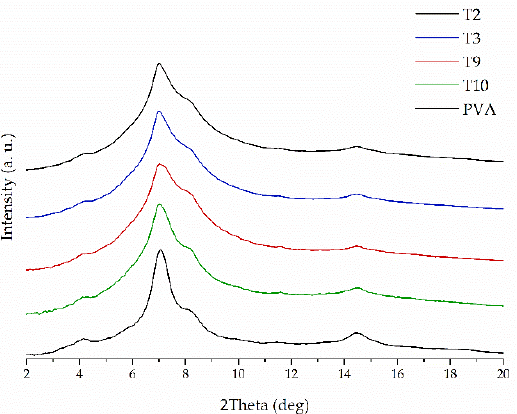
Figure 2. XRPD diffraction patterns of neat PVA and 3DP tablets containing 40% of KET with the addition of various disintegrants.